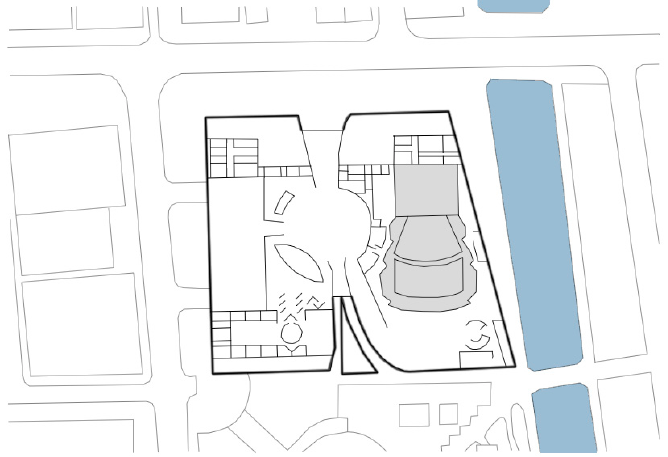
Figure 4. Projection of the Prefectural International Hall “Asian Cross Road Over the Sea”; graphic processing, based on Google Maps and [20], by E. Latusek.